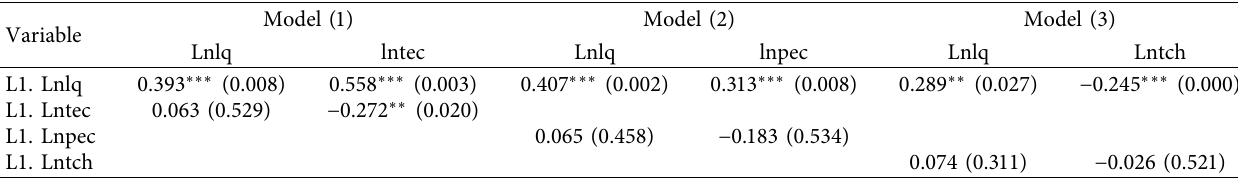
Table 4: GMM estimation results of PVAR model.